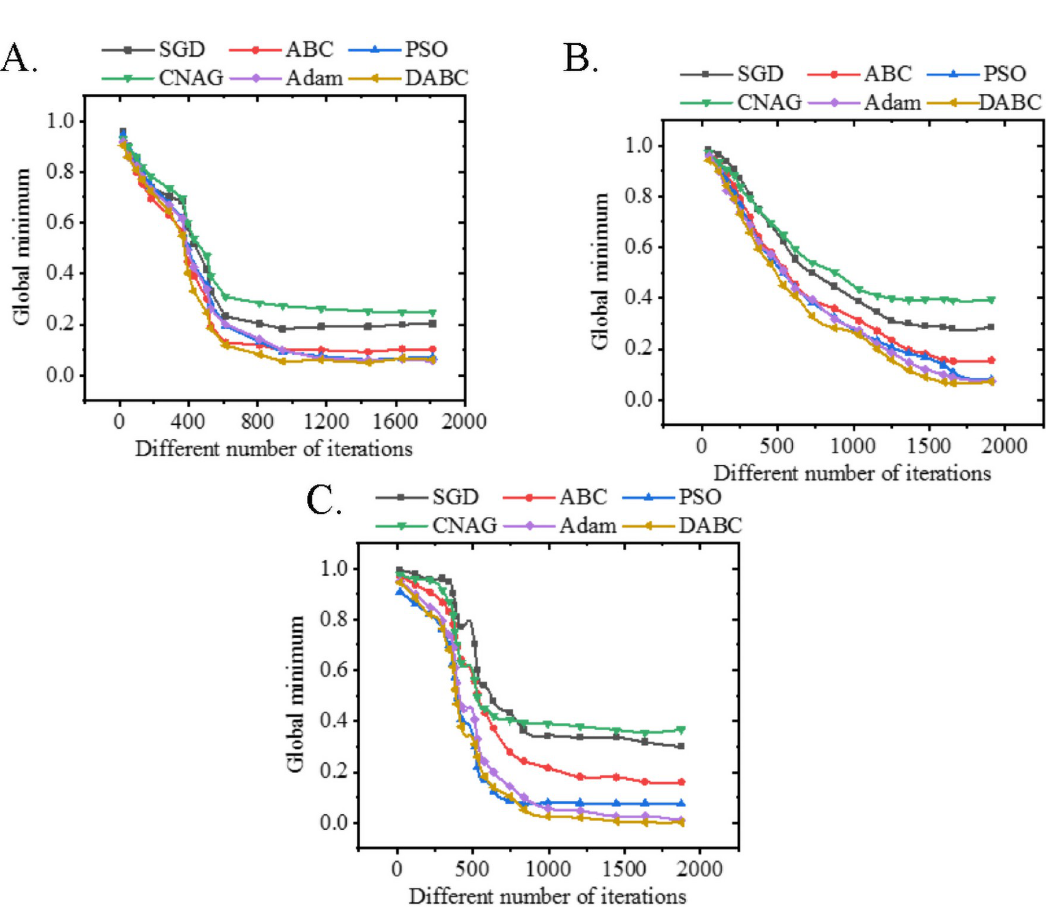
Fig 8. Results of searching performance of the improved NAG algorithm on Rosenbrock function, Ackley function, and Rastrigin function. Note: Fig 8-A represents the results on Rosenbrock function; Fig 8-B represents the results on Ackley function; Fig 8-C represents the results on Rastrigin